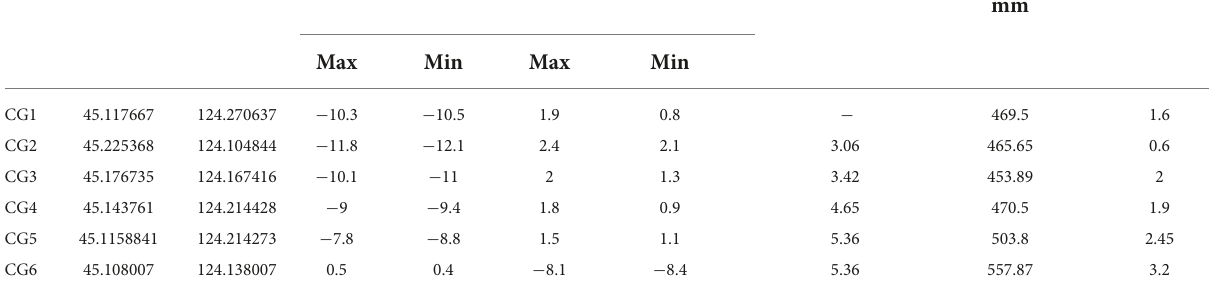
TABLE 1 Sampling site